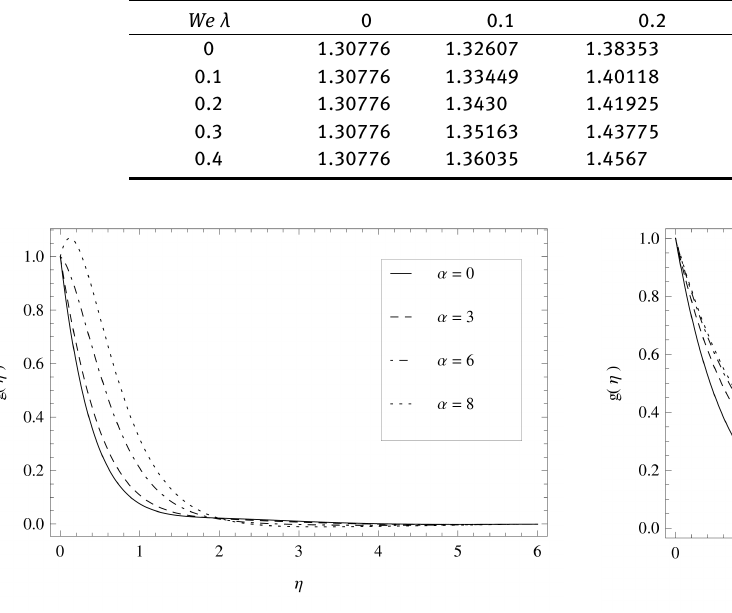
Table 2: Illustrating the variation of f (cid:48)(cid:48) (0) for various We and λ at the approximation level m = 9 , ( (cid:126) = −0.29, α = 0, M = 0, f w = 0) We λ